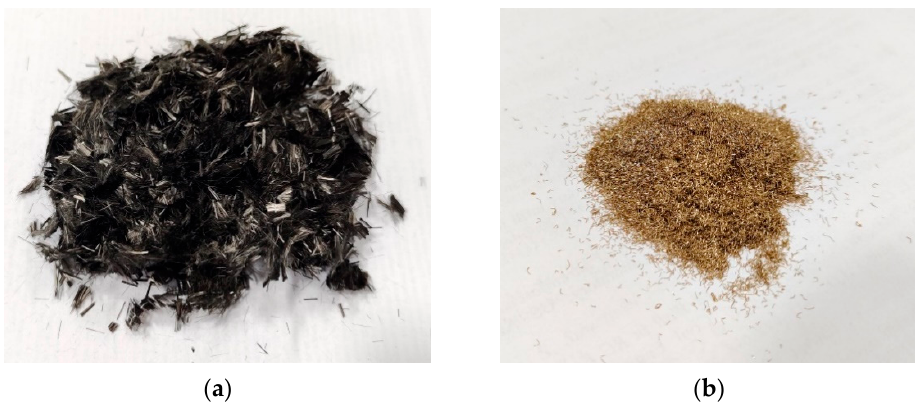
Figure 1. The pictorial representation of brass and carbon fibres. ( a ) Carbon fibre. ( b ) Brass fibre. Table 2. Mix proportion and constituents for mortar strips.